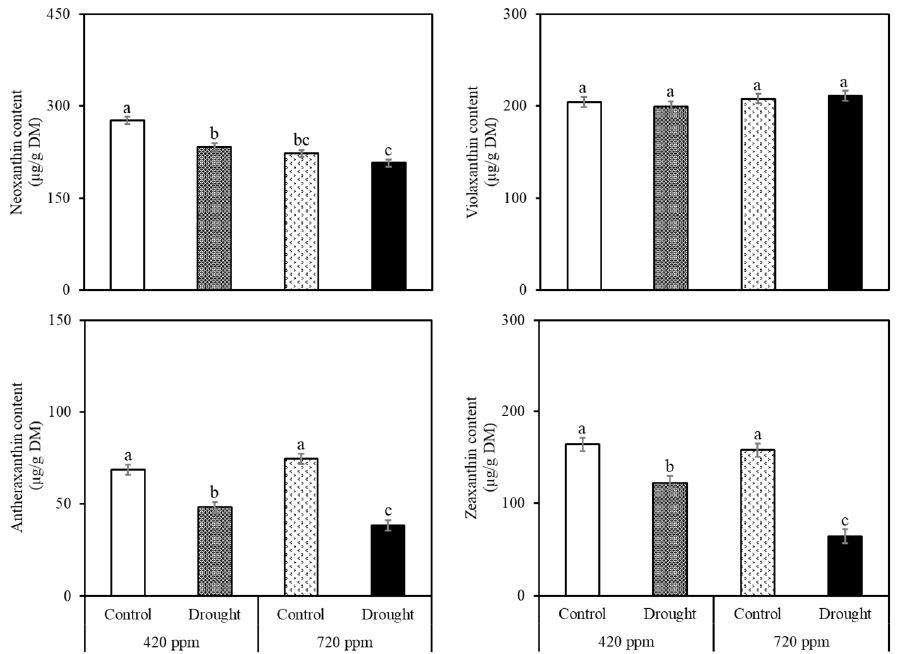
Figure 1. Neoxanthin (Neo), Violaxanthin (Vio), Antheraxanthin (Anth), and Zeaxanthin (Zea) estimation of basil plants grown without drought stress (control) and with drought stress at two levels of CO 2 (420 and 720 ppm) after 17 days of treatment. Data are presented as treatment means ± SE ( n = 10). Different low case letters indicate a significant difference at p < 0.05 by the least significant difference. DM, Dry mass.